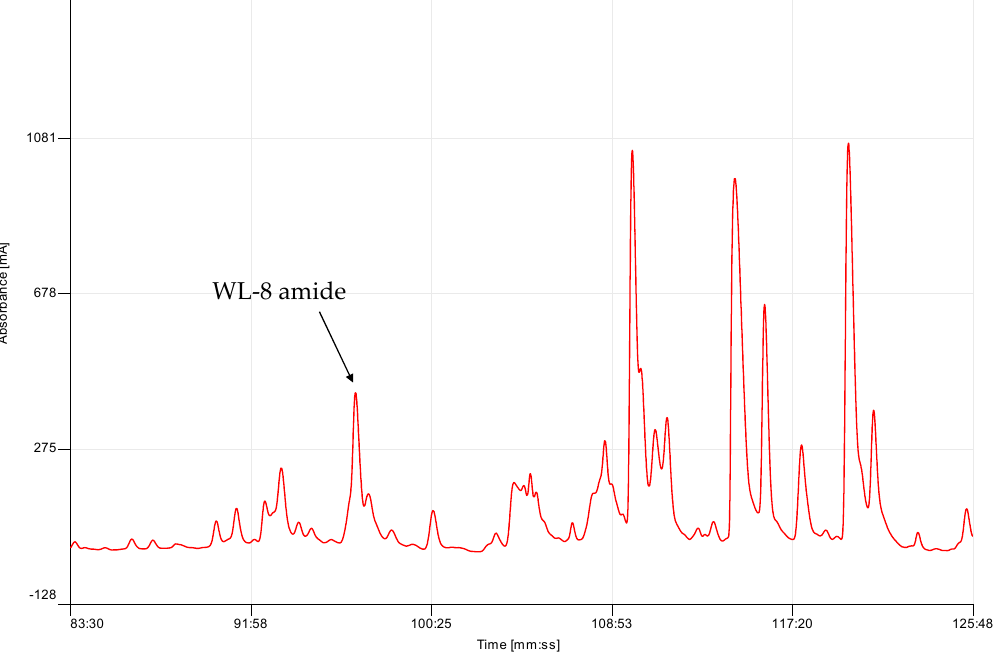
Figure 1. Region of reverse-phase high performance liquid chromatography (RP-HPLC) chromatogram of lyophilised Kassina senegalensis skin secretion. The retention time of the WL-8 peptide is 97 min (32.3% acetonitrile) and indicated by an arrow.